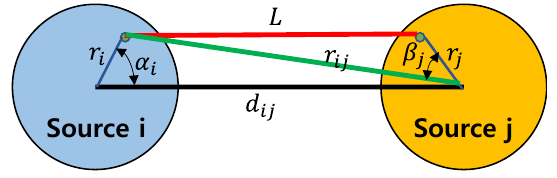
Figure 5. Arrangement of two piston sources.